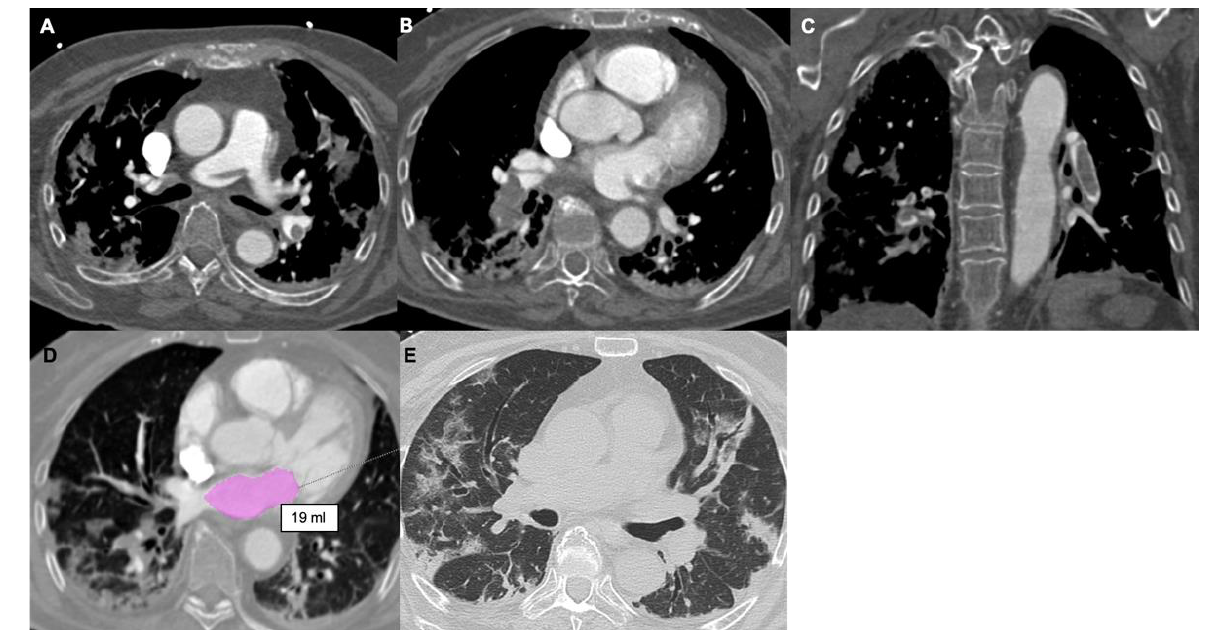
Figure 4. ( A , B ) Axial and coronal ( C ) contrast-enhanced CT scans show saddle embolism and multiple eccentric emboli involving the lower lobar branches of the pulmonary arteries. ( D ) Left atrium, purple. There is decreased LA volume, 19 mL. ( E ) Axial scans in the lung window show peripheral ground-glass opacities in association with consolidation areas involving both